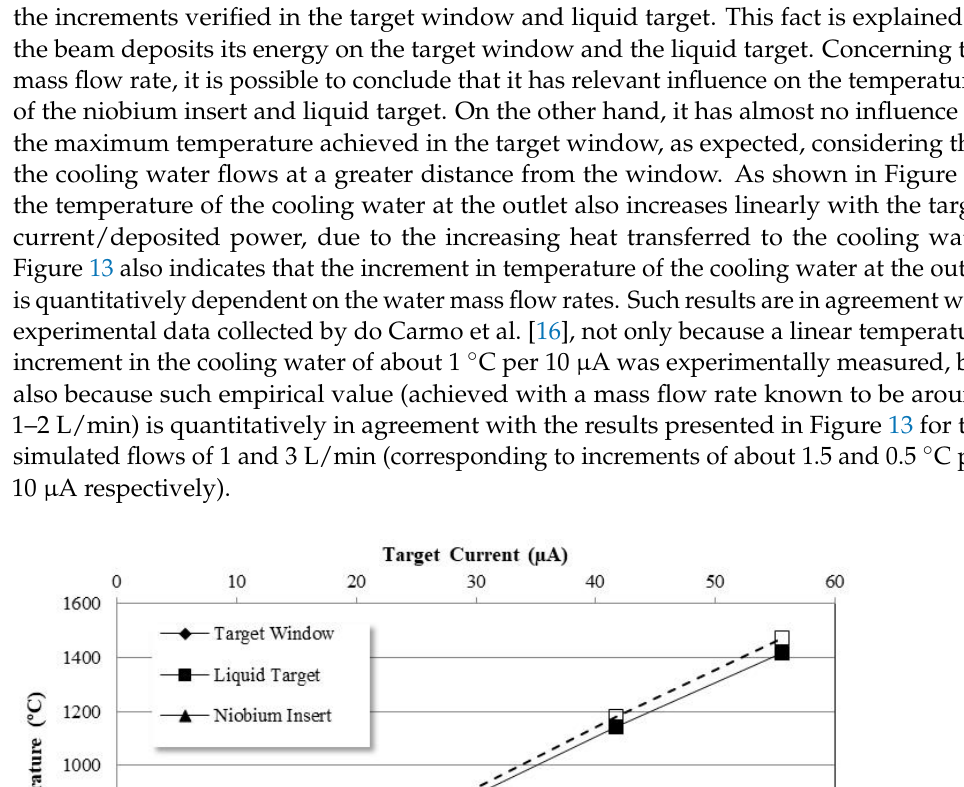
Figure 13. Absolute temperature at outlet (full symbols) and temperature increment (open symbols) for the cooling water as a function of the beam power (and corresponding target current), for two flow rates of the cooling water. Simulations runs were also conducted with different mass flow rates of the cooling water, to test the influence of the cooling water on the temperatures of the several components of the liquid target system. Figure 14 shows that decreasing the mass flow rate of the cooling water below about 3 L/s results in a significant increase of the maximum temperatures of the liquid target, the niobium insert, and, even further away, the target window. This result confirms the importance of the cooling water in removing heat from